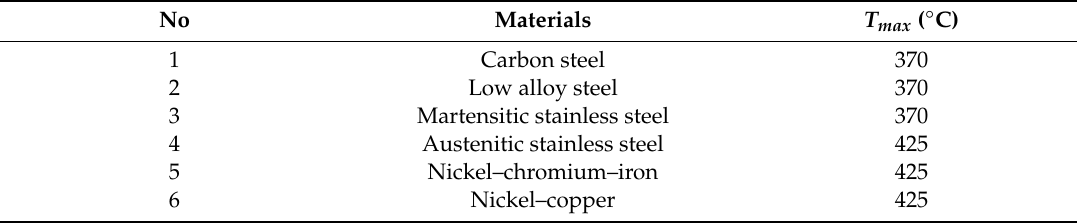
Table 1. Maximum temperature for various classes of permitted materials.